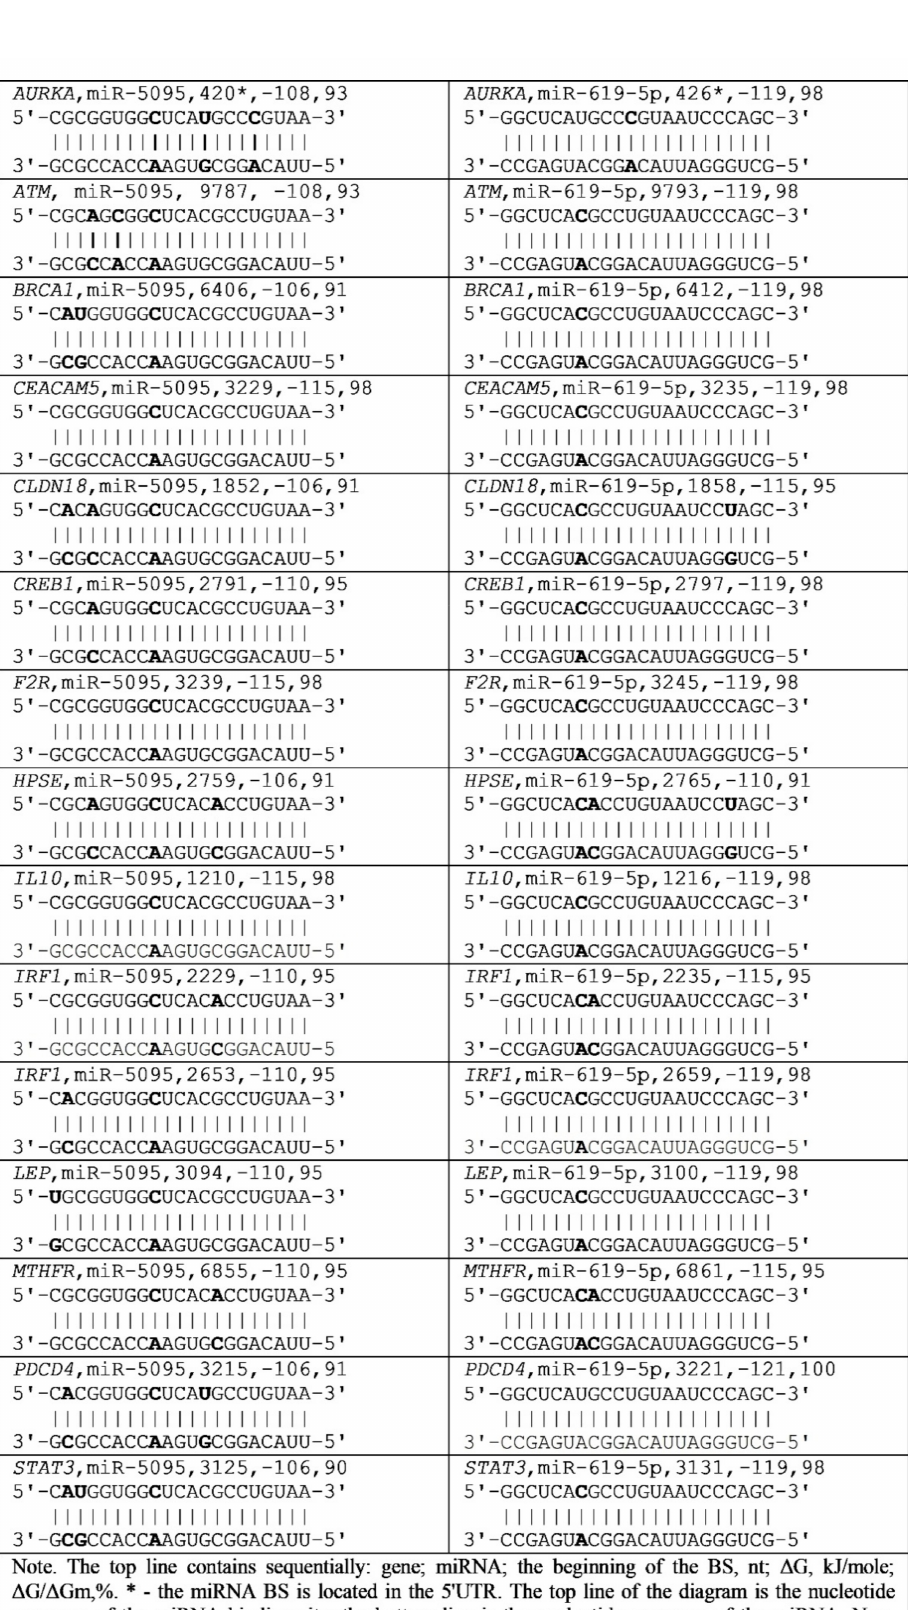
Figure 1. Schemes of interaction of miR-5095 and miR-619-5p in the 3 (cid:48) UTR of mRNA of candidate gastric cancer